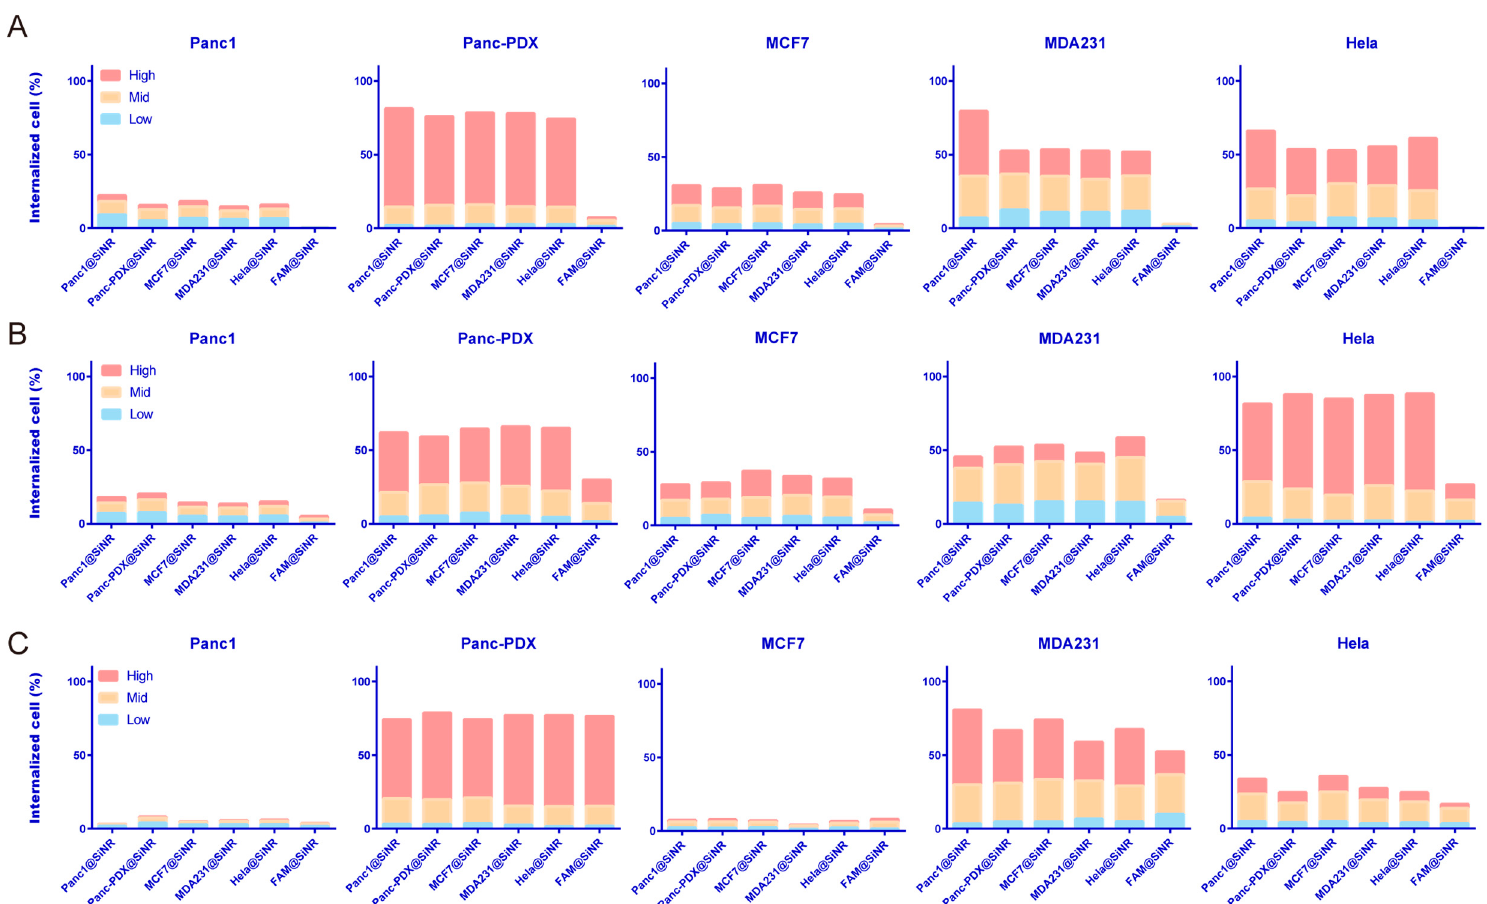
Figure 4. Cell distribution and internalization of membrane-coated SiNRs. The amount of SiNR internalized per cell was measured via an index of spot count: low internalization 0–3, middle internalization 3–10, high internalization >10. The cell distribution of different SiNR internalizations are shown in the bar plot. The FAM-linked SiNR served as a control. ( A ) L-size SiNRs were incubated with the indicated cell line. ( B ) M-size SiNRs were incubated with indicated cell line. ( C ) S-size SiNRs (100 nm diameter) were incubated with the indicated cell line. The FAM-linked SiNR served as a control.